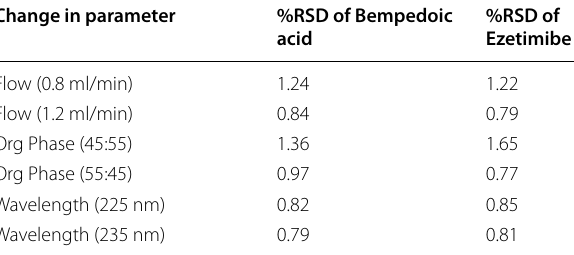
Table 5 Results of robustness of Bempedoic acid and